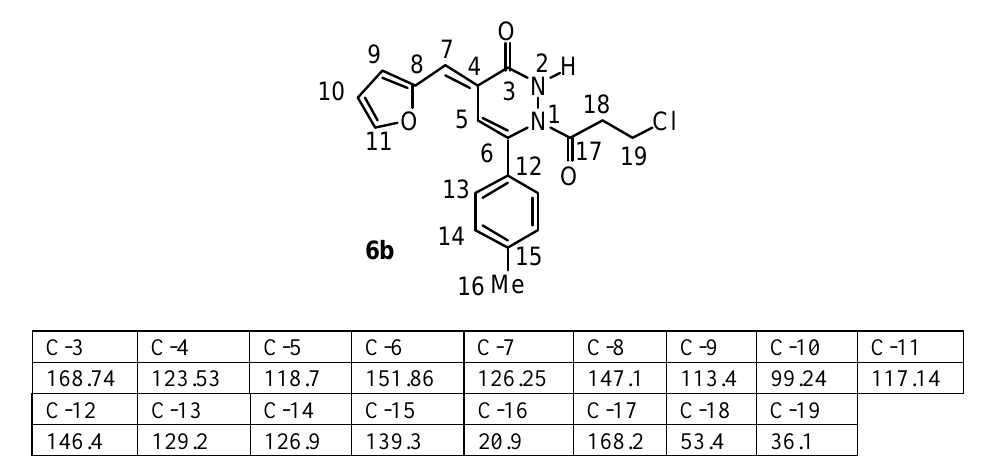
Table 3. 13 C Chemical shifts ( d C[ 2 H